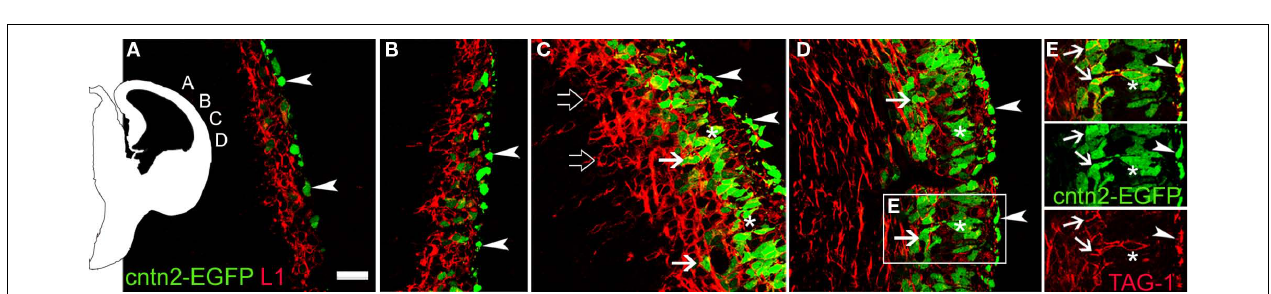
development gradient, where TAG-1 + or CB + cells accumulated in the ventrolateral extreme of the subplate. CB and TAG-1 localized in independent tissue elements. Note in (G) that subplate contained both TAG-1 + cells and the deepest CB + cells (arrows). ChPl, choroid plexus; DT, dorsal thalamus; EmT, Eminentia thalami ; ET, epithalamus; ic, posterior limb of the internal capsule; SP, subplate. VT, ventral thalamus; VZ, ventricular zone; zli, zona limitans intrathalamica. Rat, E15.5. Confocal Z-stacks. Calibration bars: (A,A ′ ) 100 µm; (B) 200 µm; (C–G) 30 µm.